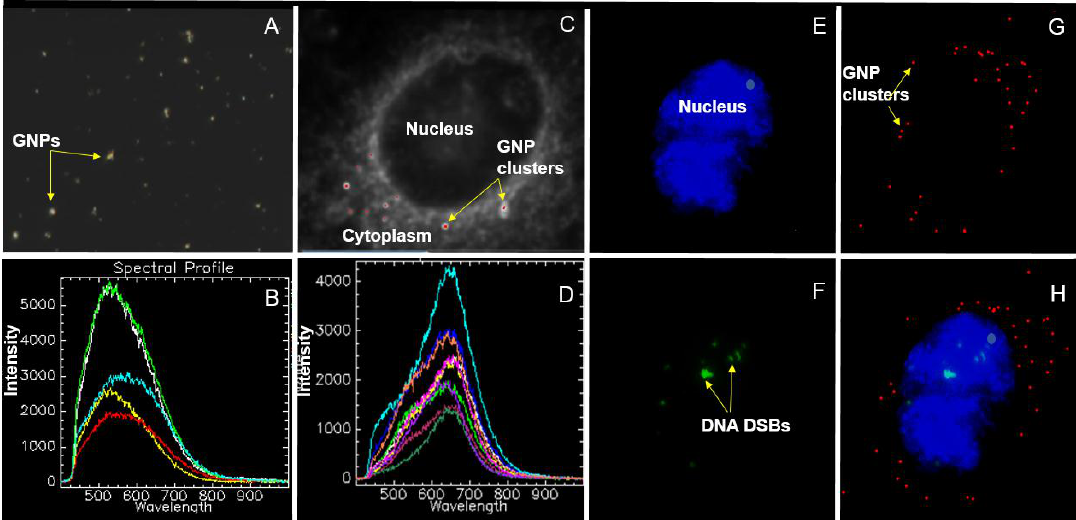
Figure 2. Imaging of GNPs using hyperspectral imaging technique: ( A ) Dark-field image of GNPs; ( B ) reflectance spectra of a few GNPs shown in ( A ); ( C ) dark-field image of an unstained cell with internalized GNP clusters (bright white spots); and ( D ) reflectance spectra of few GNP clusters localized within the cell shown in ( C ). ( E–H ) Hyperspectral image of a stained (nucleus and DNA Double Strand Breaks (DSBs)) cell. Three different channels were used to display nucleus, GNPs, and DNA DSBs. Blue areas are nuclei of the cell ( E ); green dots represent DNA DSBs ( F ); and red dots represent GNP clusters localized within cells ( G ); ( H ) A merged image of the three channels corresponding to the nucleus, GNPs, and DNA DSBs).